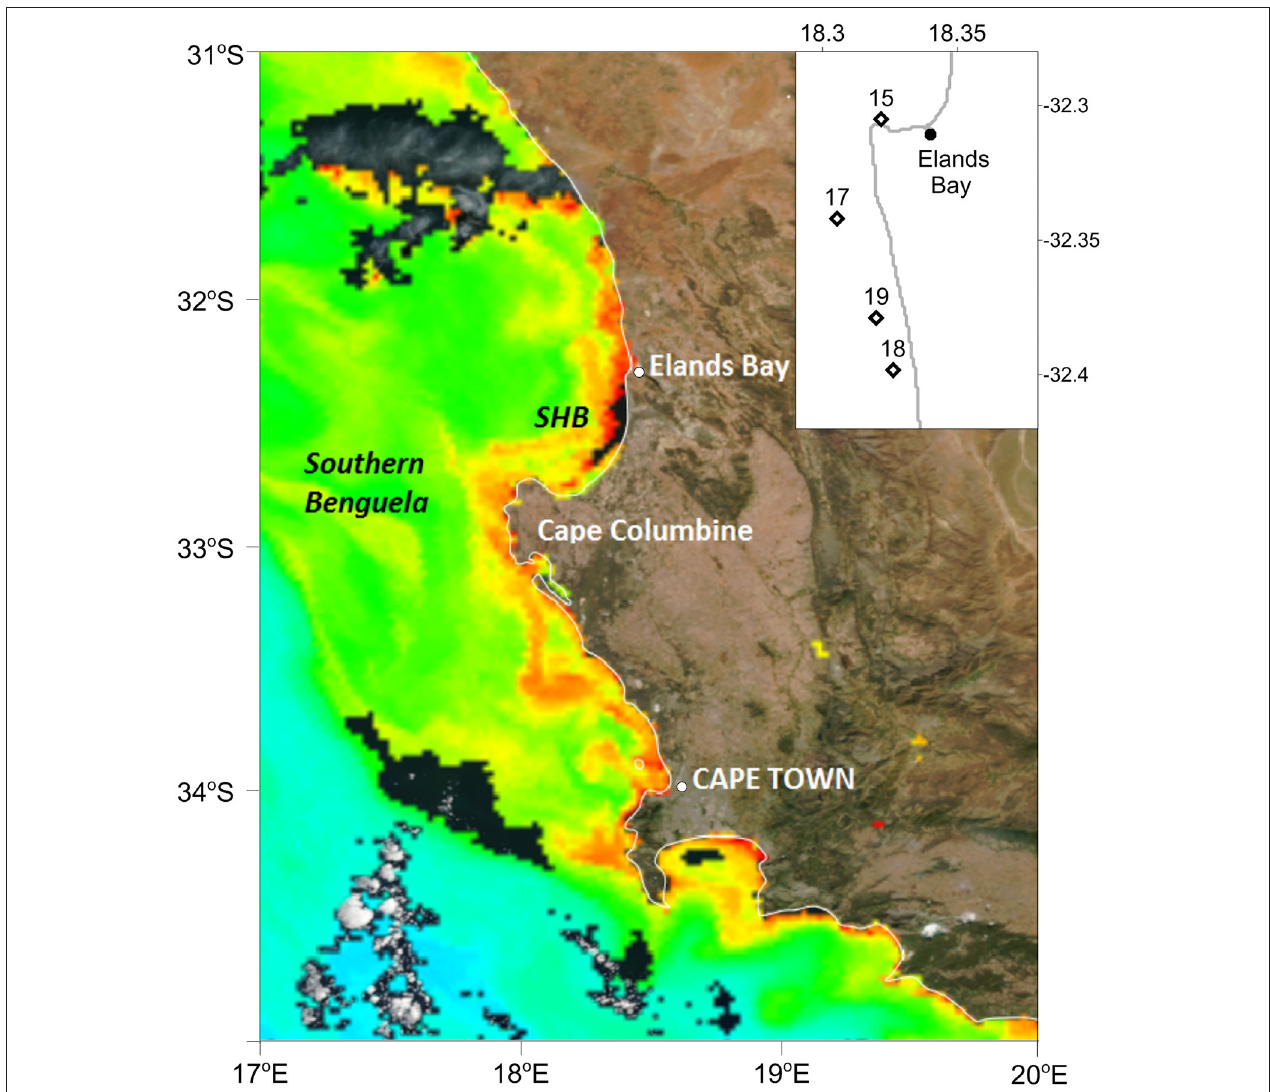
FIGURE 1 | Station positions in St. Helena Bay (SHB) sampled on the 15, 17, 18, and 19 March 2013 inserted on a Chl a ocean color image generated by the NOAA/NESDIS Center for Satellite Applications and Research. Data acquired from the Visible Infrared Imaging Radiometer Suite (VIIRS) on board the Suomi National Polar-orbiting Partnership satellite on the 19 March